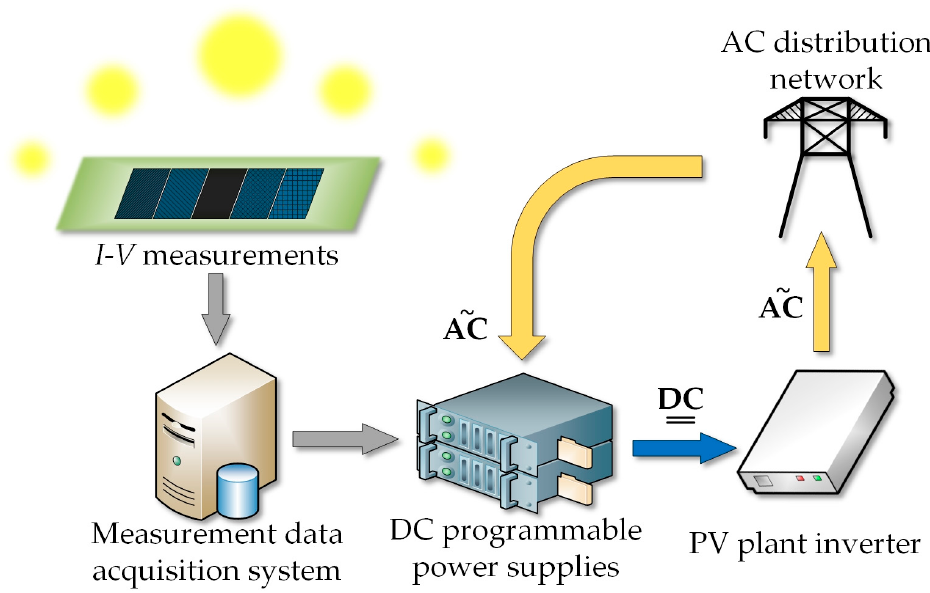
Figure 1. Fast photovoltaic (PV) power emulation procedure.